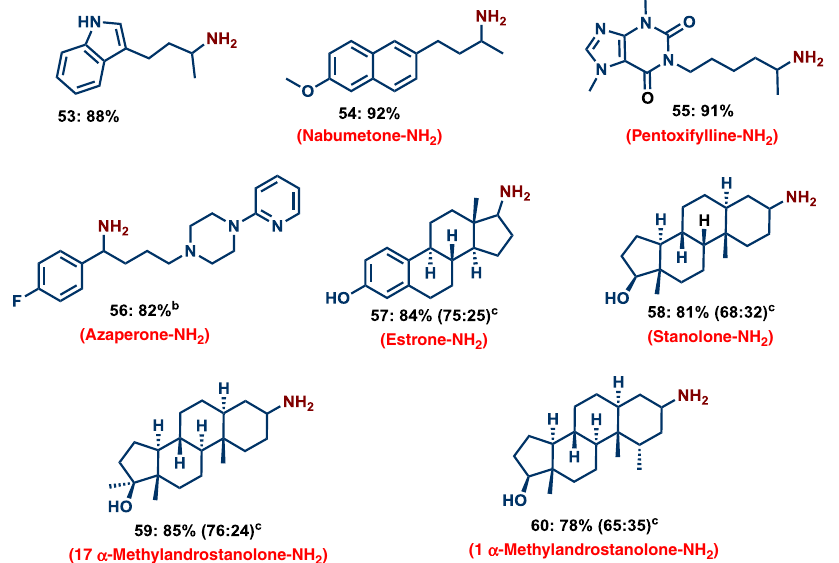
Fig. 3 Co-catalyzed amination of bioactive compounds. Reaction conditions: a 0.5 mmol substrate, 3 mol% Co(BF 4 ) 2 ⋅ 6H 2 O, 4 mol% triphos ( L7 ), 5 – 7 bar NH 3 , 40 bar H 2 , 2 mL degassed TFE, 120 °C, 24 h. b Same as ‘ a ’ with 50 bar H 2 . c Diastereomeric ratio. Isolated as free amines and converted to hydrochloride salts. Corresponding hydrochloride salts were subjected to NMR